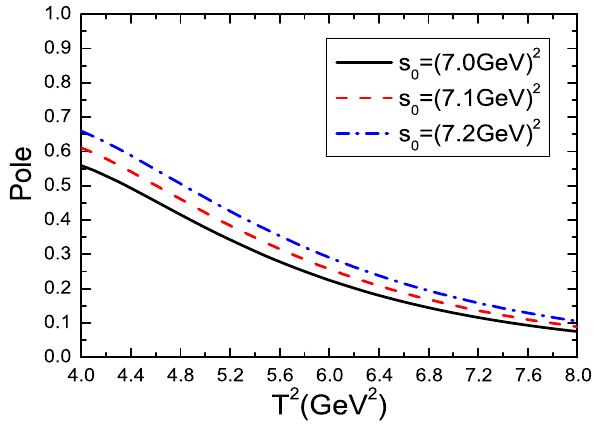
Fig. 3 The pole contribution of the Z ++ cc with variation of the Borel parameter T 2